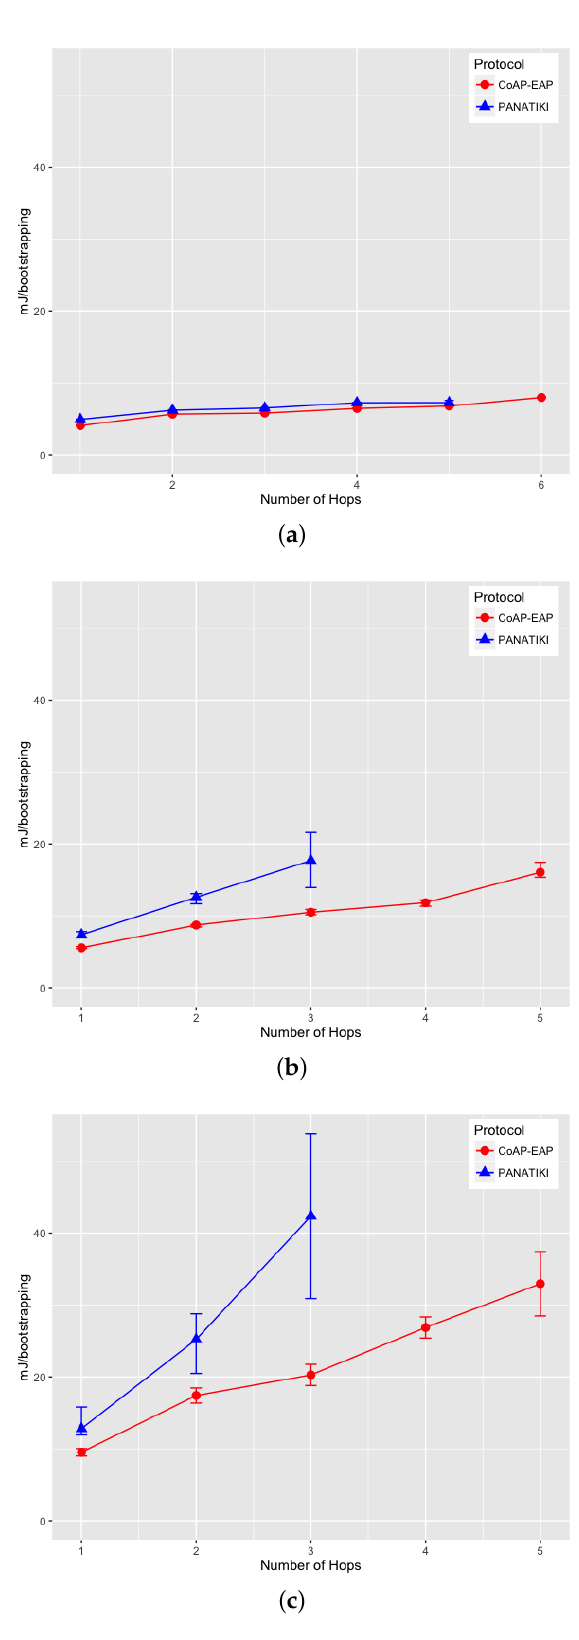
Figure 14. RX energy consumption. ( a ) RX energy consumption with 0.0 loss ratio; ( b ) RX energy consumption with 0.1 loss ratio; ( c ) RX energy consumption with 0.2 loss